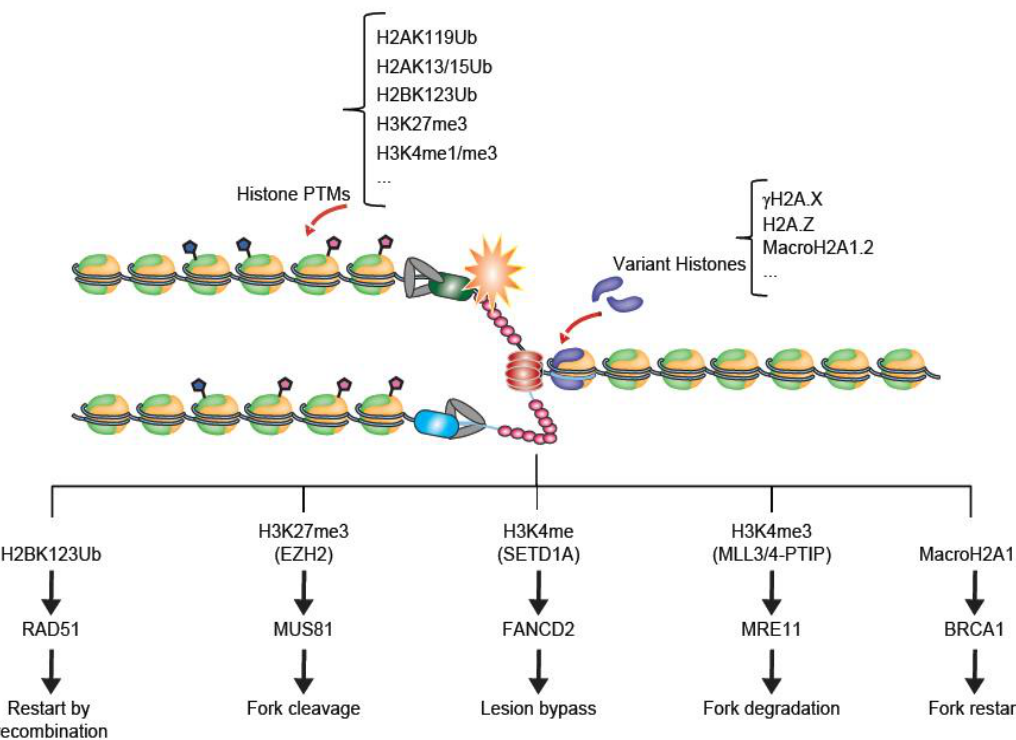
Figure 2. Examples of histone modifications and variants at stalled replication forks. A replication fork stall (orange star) can lead to the exposure of single-stranded DNA (ssDNA) as the helicase separates from the polymerase. This serves as a signal for replication stress which can catalyse local histone modifications or variant incorporation (see main text). Below, five representative outcomes described in this review are shown. In each case, the chromatin-level change is noted at the top and a fork protection and restart protein is recruited to lead to resolution for the stalled fork. In reality these events are certain to be highly coordinated with one another.